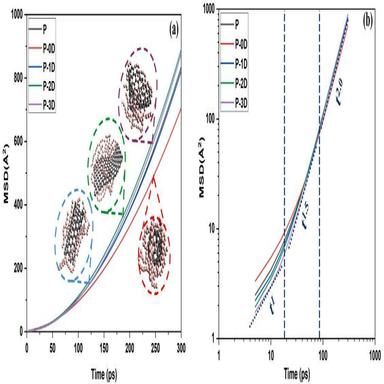
MSD components plotted separately for the , and -directions from (a1) to (a5) for P to P-3D, respectively.